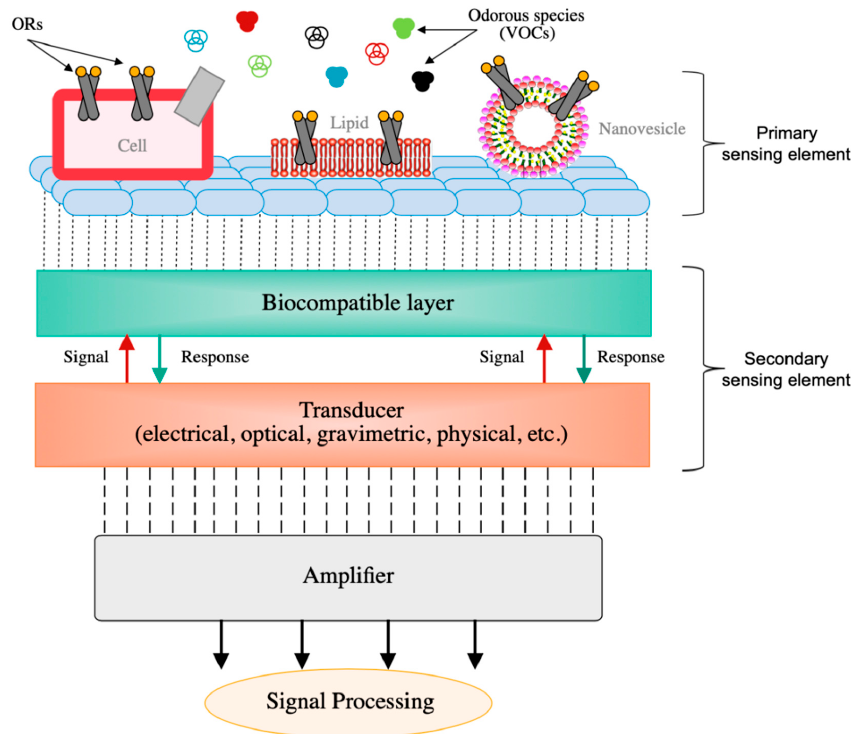
Figure 8. Schematic representation of a typical bioelectronic sensor device for the detection of odorous species (VOCs). These devices are generally constituted of a primary sensing element (i.e., biological element) and a secondary element used to capture and amplify the responses of bioreceptors [153]. Olfactory receptors (ORs) can be deployed onto these devices by means of cells or tissues, lipid layers, and nanovesicles [178].